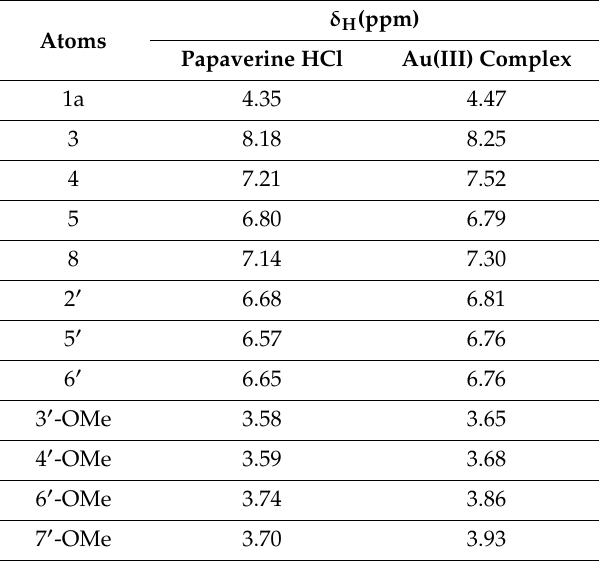
Table 3. 1 H-NMR characteristics of papaverine HCl and its Au(III) complex.